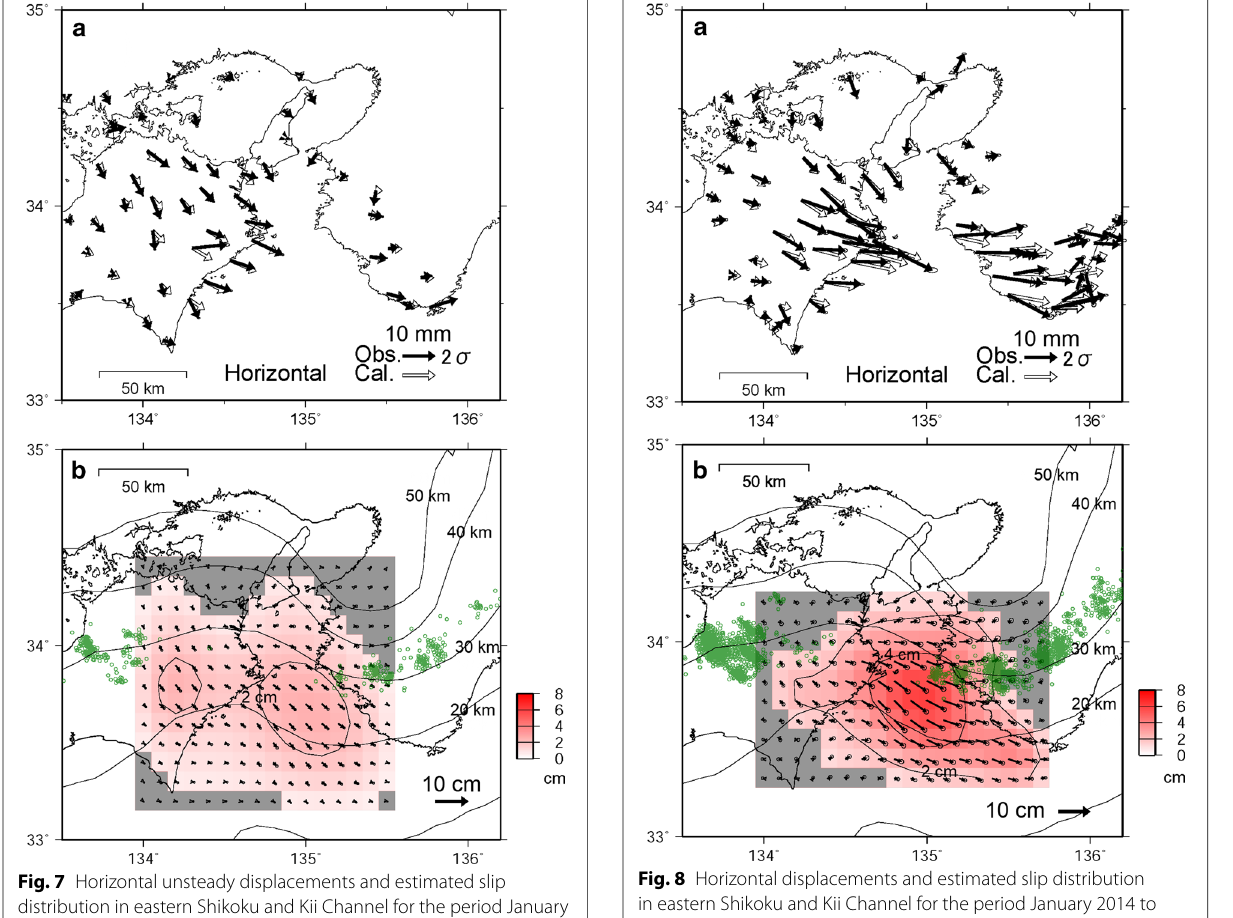
the slip at depth occurs in a narrow region.